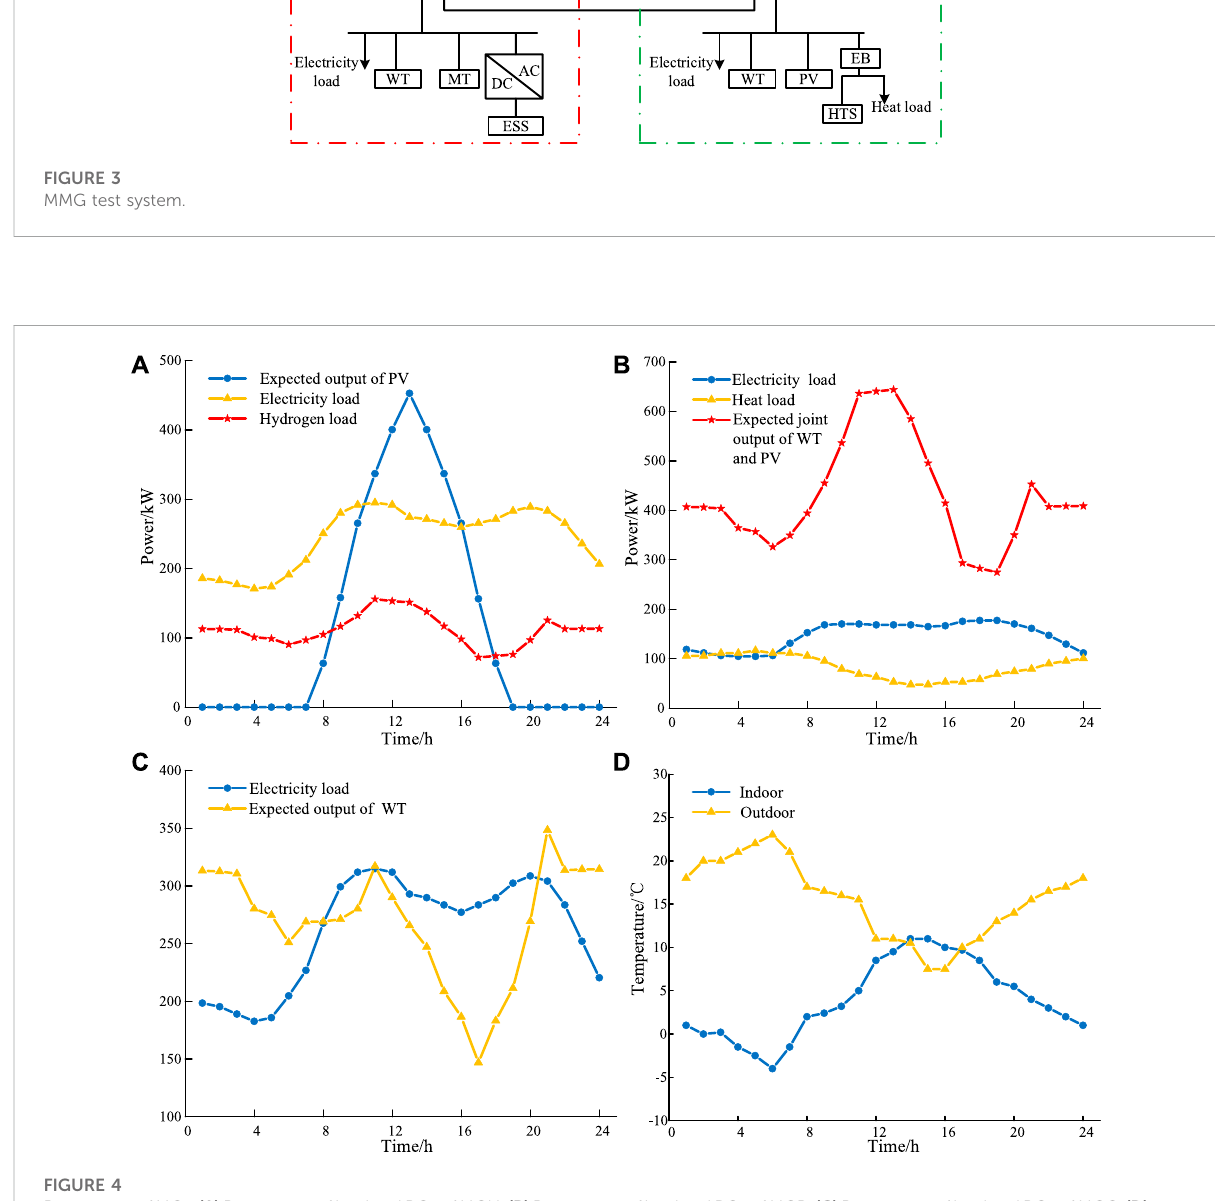
FIGURE 4 ParametersofMGs. (A) ParametersofloadandRGsofMGH. (B) ParametersofloadandRGsofMGB. (C) ParametersofloadandRGsofMGC. (D) Indoor and outdoor temperature of